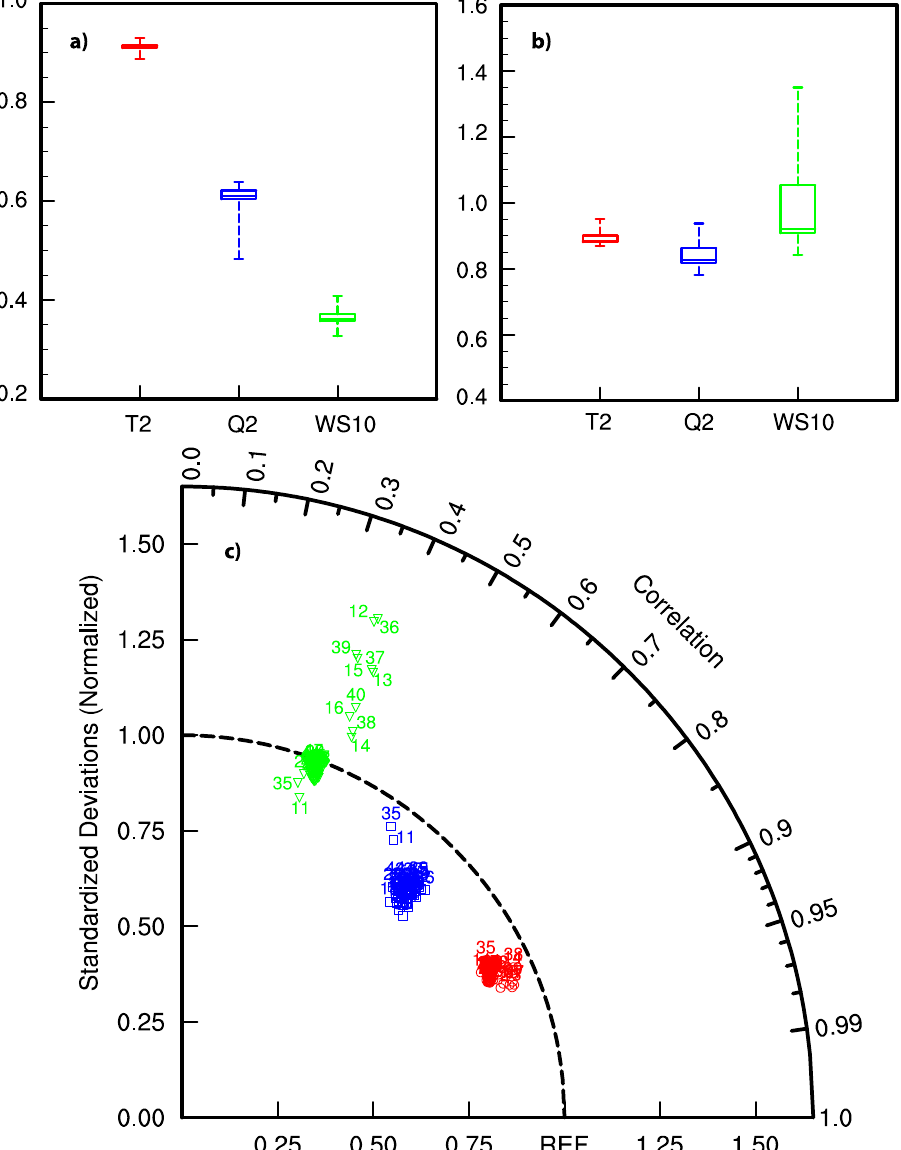
Figure 5. Same as Figure 3, but for the one-week study period in July.